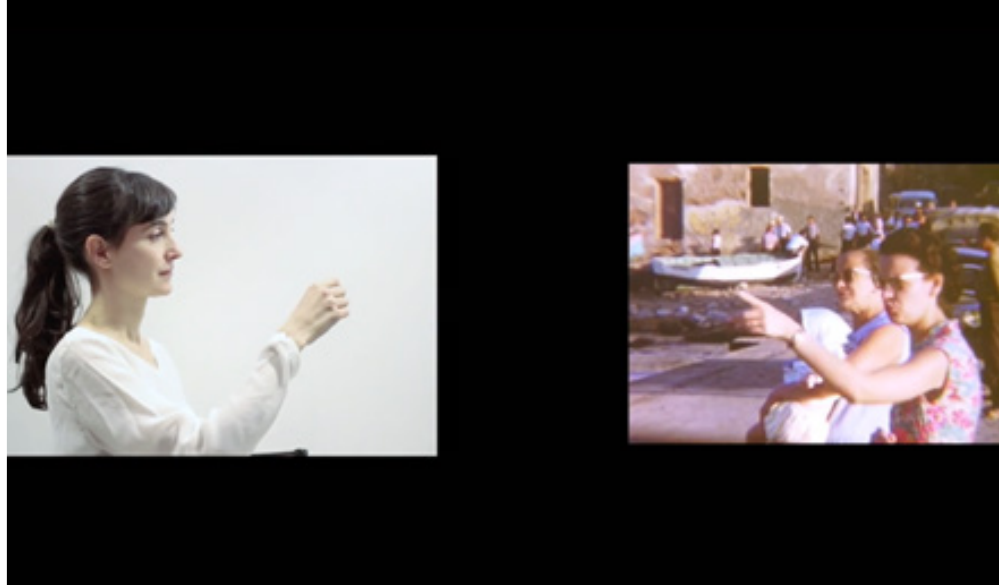
Fig. 1 Screenshot from Let’s Reset the Clock , 2’37” colour